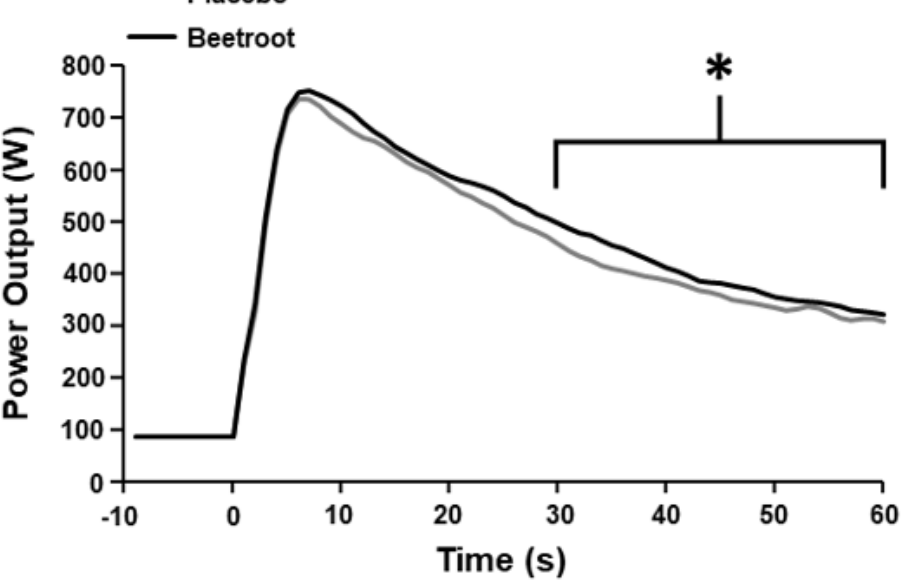
Figure 2. Mean power output during the 60 s end-sprint following 2 h moderate-intensity exercise after ingestion of nitrate-depleted beetroot (placebo) and nitrate-rich beetroot (beetroot) powder. * Higher than placebo ( p < 0.001). Error bars are omitted for clarity.